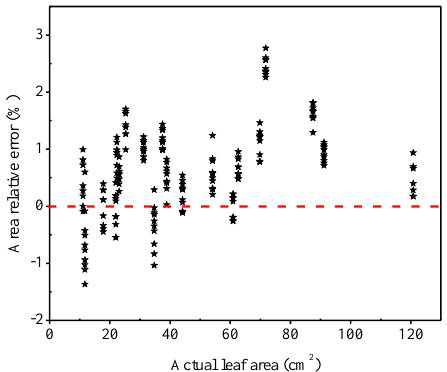
Figure 12. The relationship between the relative error of the leaf area measured by the developed system and the leaf area measured by the grid method